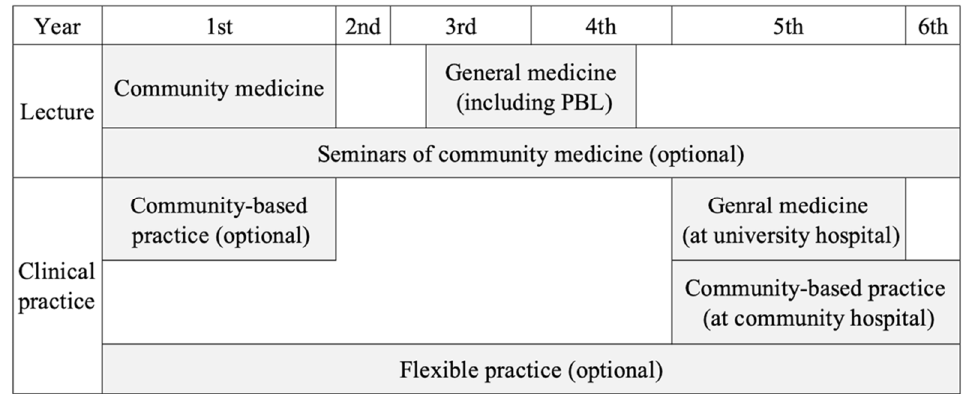
Figure 2. The general medicine curriculum of Shimane University Faculty of Medicine as of 2021.